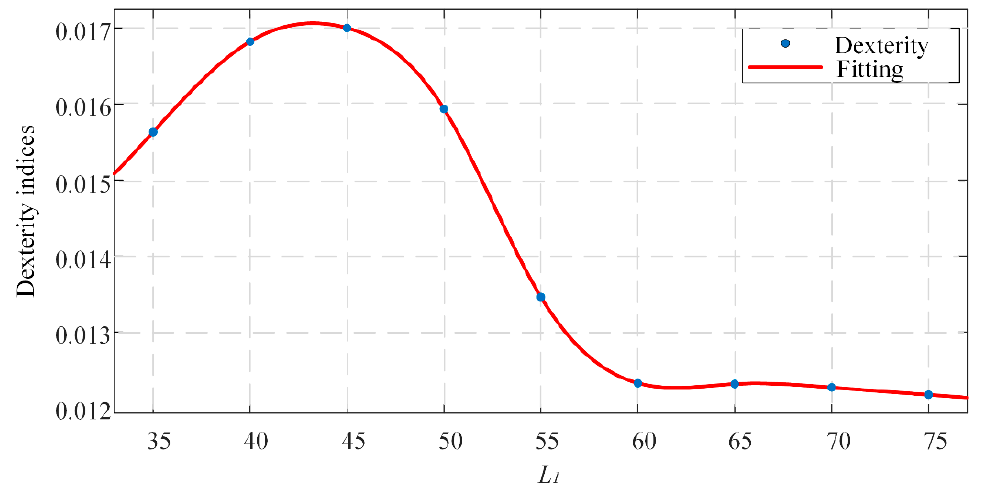
Figure 14. Fitted model.